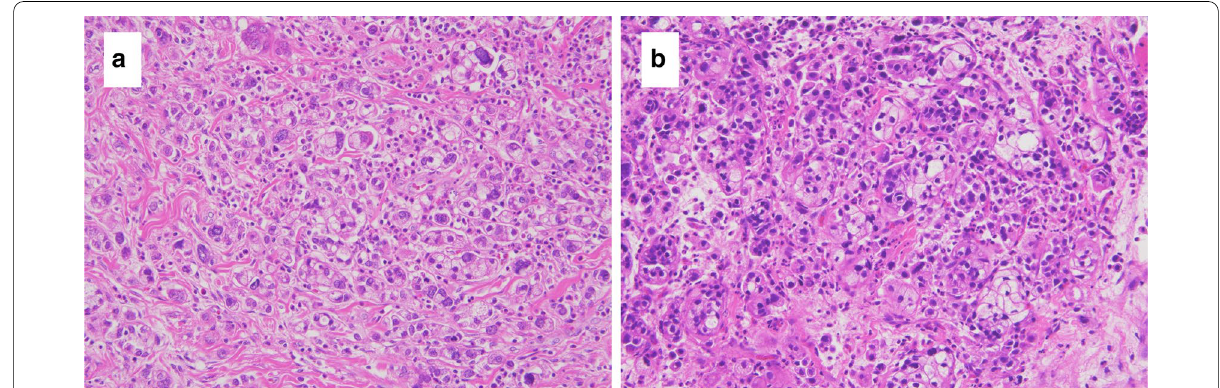
Fig. 3 Microscopic appearance of the resected stomach and gluteal muscle mass. a Pathological specimens of the resected stomach reveals poorly differentiated adenocarcinoma and signet cell carcinoma (H&E